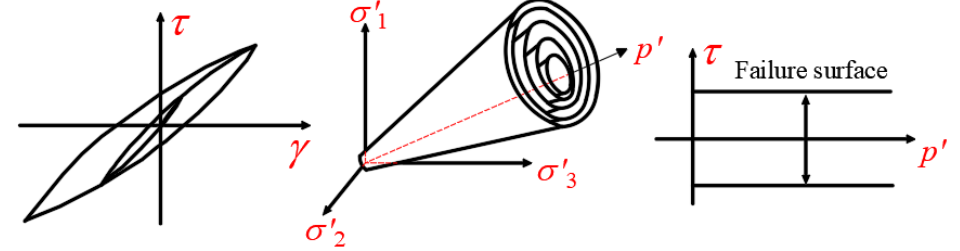
Figure 1. The stratum-station system FEA model (units in m).